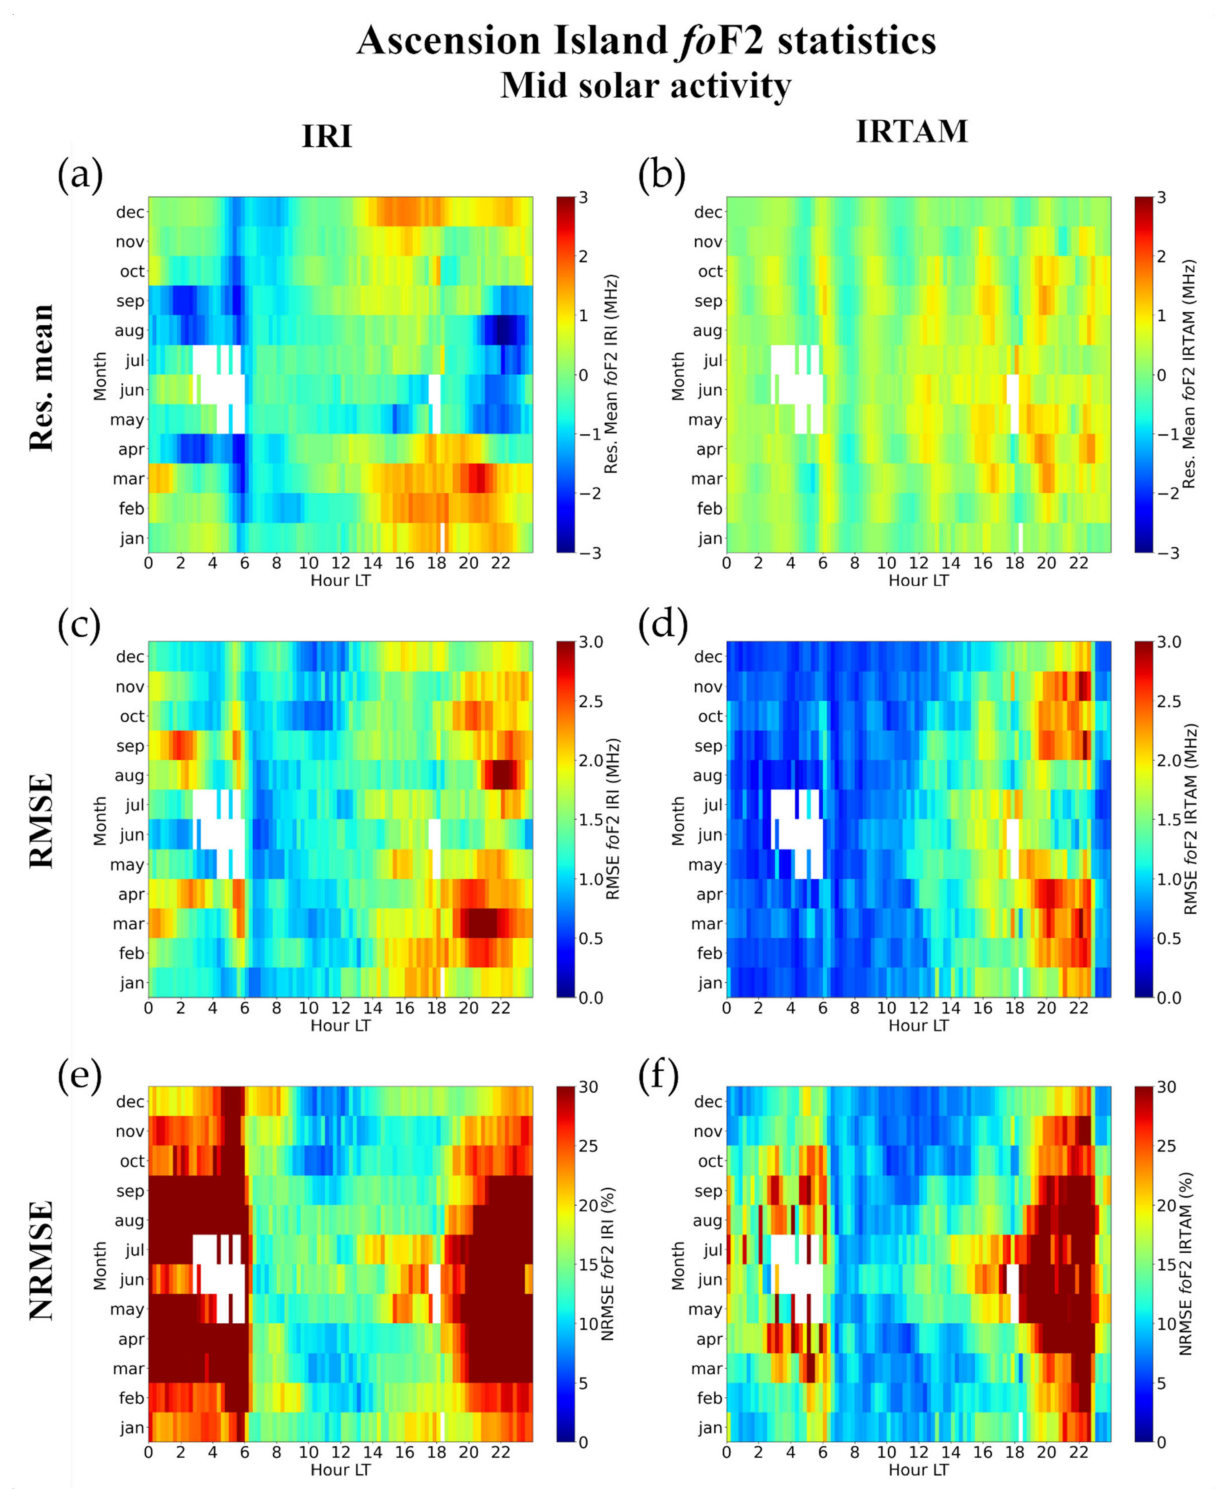
Figure 8. Same as Figure 7 but for MSA